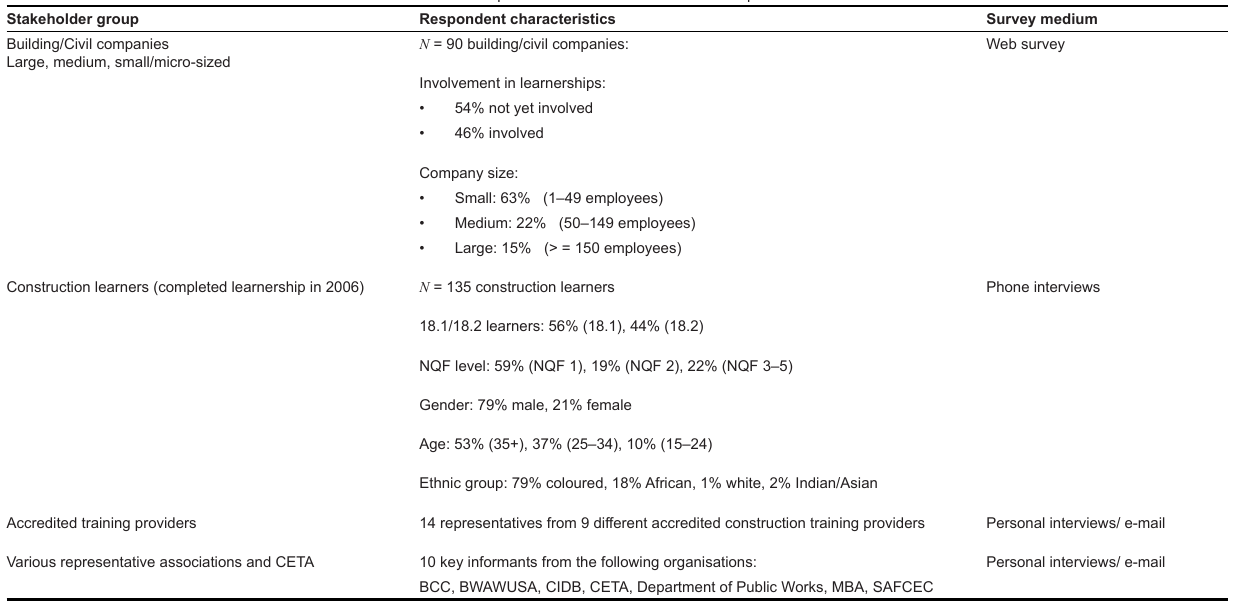
TABLE 1 Respondent characteristics – Western